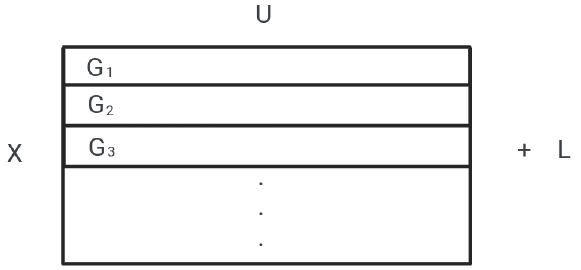
Figure 2. Visual representation of dividing G into